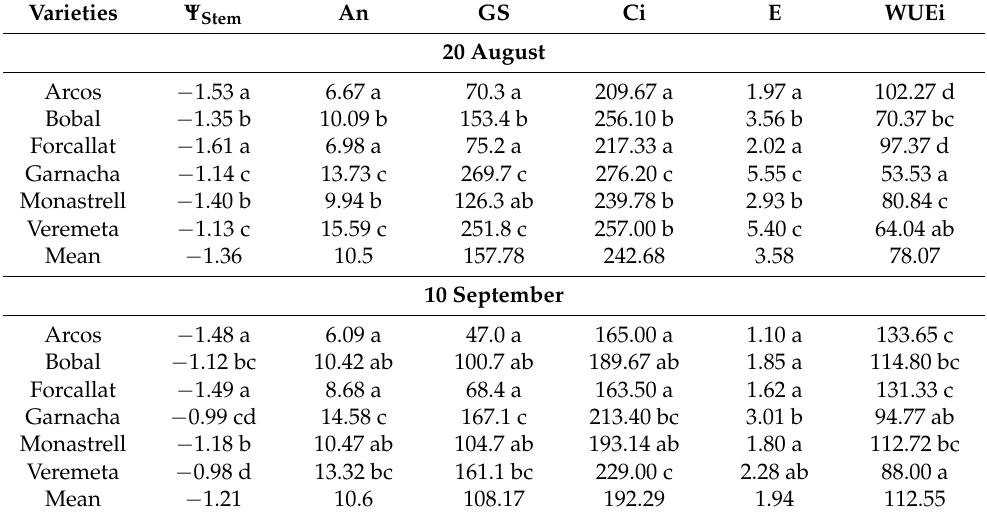
Table 4. Determination of midday stem water potential ( Ψ stem) and leaf gas exchange related parameters in 2021.